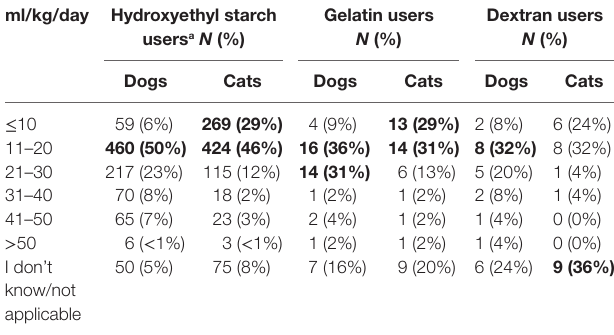
Frequently reported doses ( > 25% of respondents) are given in bold font. a For details of the maximum daily dose for each HES product, see supplemental material.